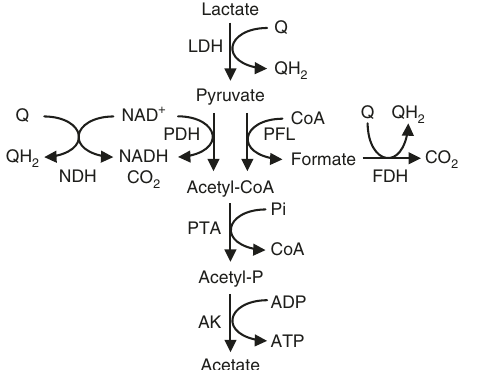
Fig. 2 Catabolic pathways of lactate to acetate in S. oneidensis MR-1. LDH lactate dehydrogenase, Q oxidized form of quinone, QH 2 reduced form of quinone, NDH NADH dehydrogenase, PDH pyruvate dehydrogenase, PFL pyruvate formate-lyase, PTA phosphotransacetylase, AK acetate kinase ( fdnGHI ) is predicted to encode a selenocysteine-containing FDH similar to the nitrate-inducible Fdh-N in Escherichia coli 30,31 .